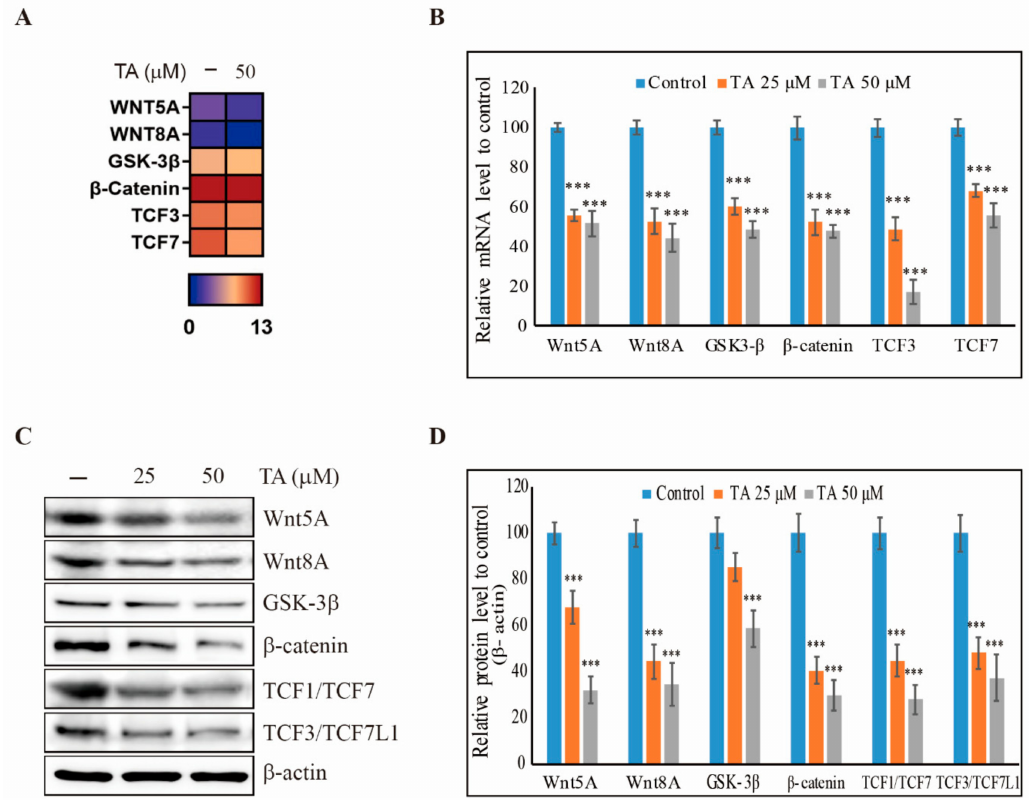
Figure 2. TA inhibits Wnt / β -catenin signaling in NCCIT cells. ( A ) Heat map showing the fold changes relative to the mean expression of Wnt / β -catenin pathway in non-treated and TA-treated NCCIT cells for 48 h. ( B ) Real-time PCR data of mRNA after treatment with TA for 48 h showing the relative expression levels of the Wnt / β -catenin pathway and normalized to GAPDH mRNA. Controls are set to 100. Data are representative of three independent experiments. *** p < 0.001 ( t -test). ( C ) Western blotting analysis of NCCIT cells with 25 µ M and 50 µ M of TA for 48 h showing the inhibition of Wnt5A, Wnt8A, glycogen synthase kinase 3 β (GSK-3 β ), β -catenin, transcription factor 1 (TCF1) / TCF7, and TCF3 / TCF7L1 expressions. ( D ) The representative expressions of proteins were determined via densitometry and normalized to β -actin. Controls are set to 100. Data are representative of three independent experiments. *** p < 0.001 ( t